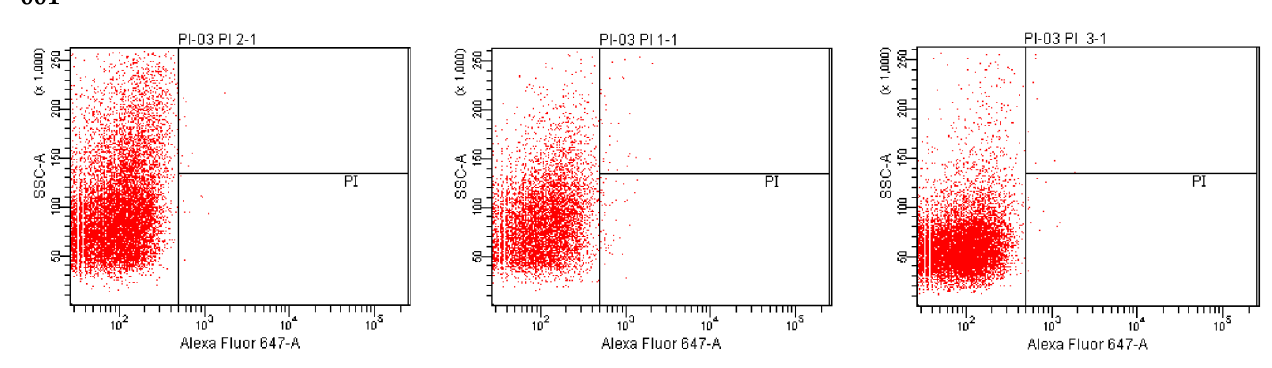
Figure 6. Action of ISO and AFB on C. tropicalis biofilms. ( a ) Biofilm formation at 37 °C for 48 h, where OD 590 > 3 indicates strong biomass production in biofilms. ( b ) Percentage reduction of biofilms after 1 h of treatment with ISO MIC for each isolate and AFB (50 µg/mL). The results of the ANOVA showing a value of p < 0.05 and the Tukey test with a confidence level of 95% indicate that there is a significant difference between the effect of ISO and the effect of AFB on the reduction of biofilms.